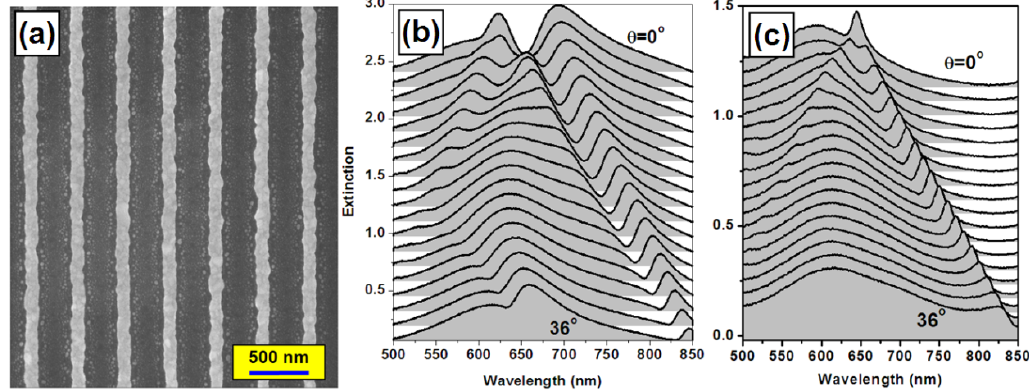
Figure 2. ( a ) SEM image of a WMPC device; ( b , c ): angle-resolved tuning properties of the optical extinction spectrum of the WMPC device for TM and TE polarization,